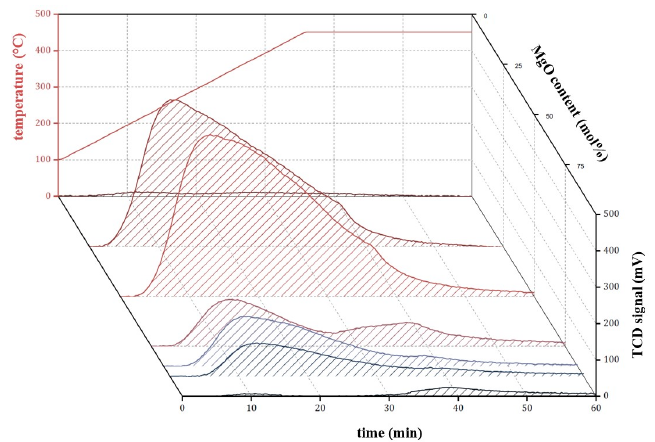
Table A2. Characterization results of the textural and surface acid investigations on the binary M1/SiO 2 mixed oxides and the precursors M1 and SiO 2 , shown in Figure 5. MgO Content (mol%)